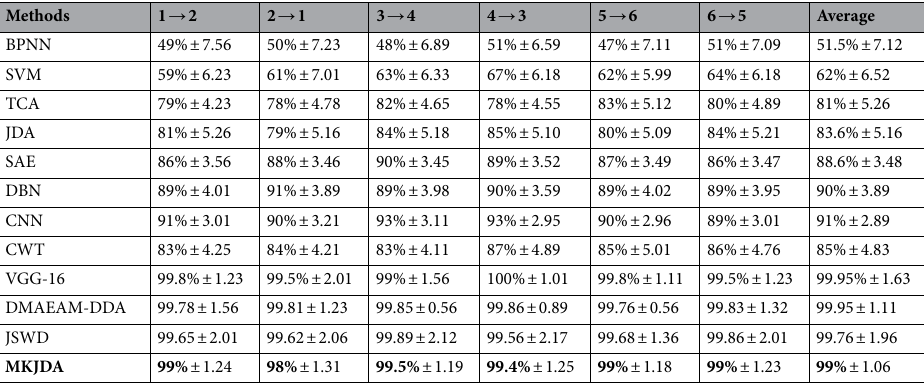
Table 9. The experimental results with three